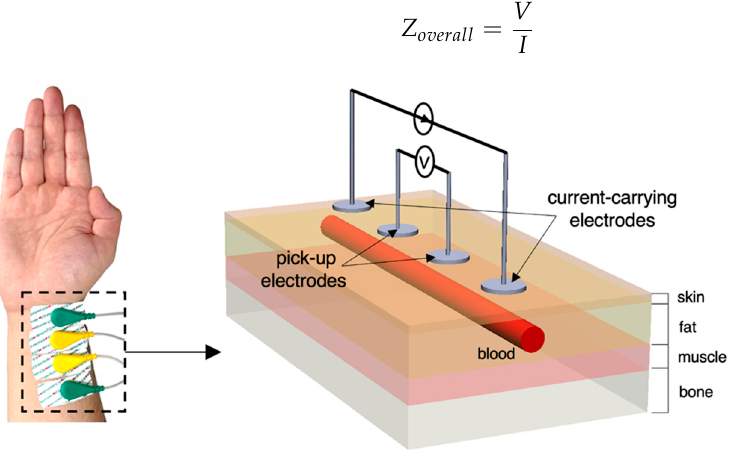
Figure 1. Overview of four ‐ spot electrodes BIM on the human wrist and the equivalent